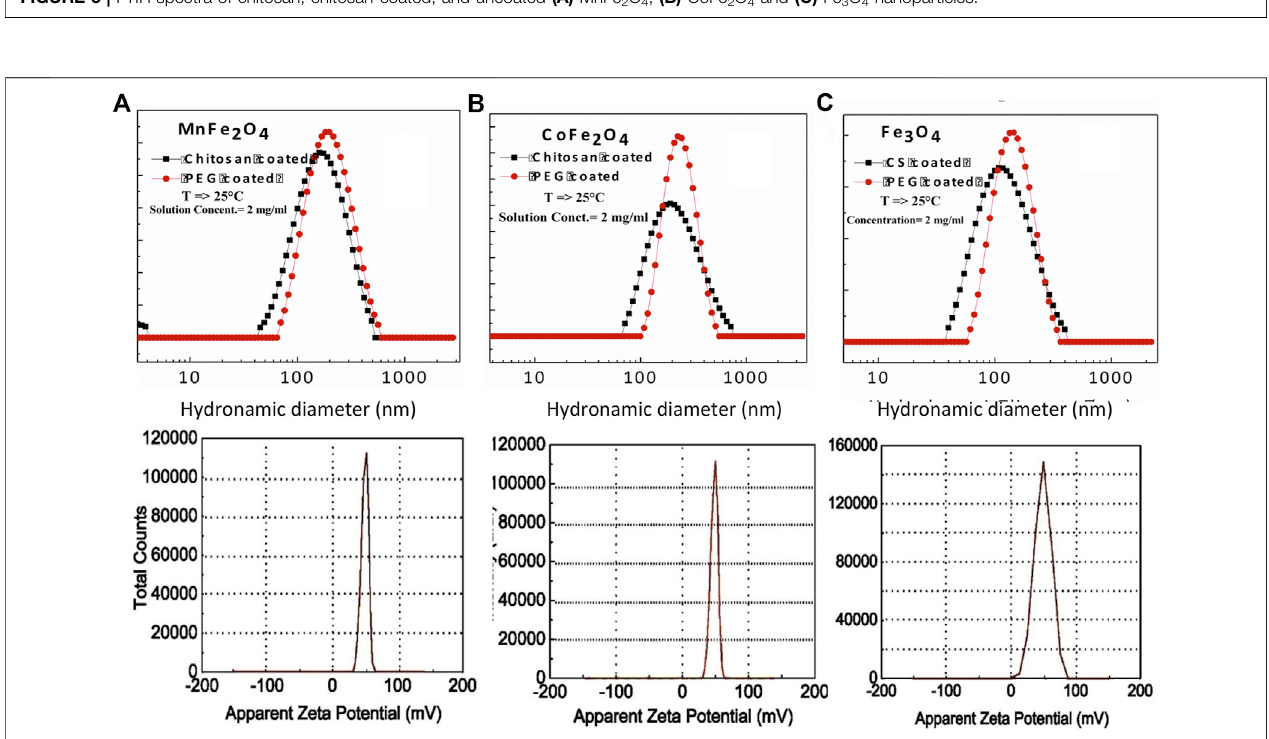
FIGURE 6 | Hydrodynamic diameter, polydispersity index, and Zeta potential of chitosan-coated (A) MnFe 2 O 4 , (B) CoFe 2 O 4 and (C) Fe 3 O 4 nanoparticles as determined by DLS.